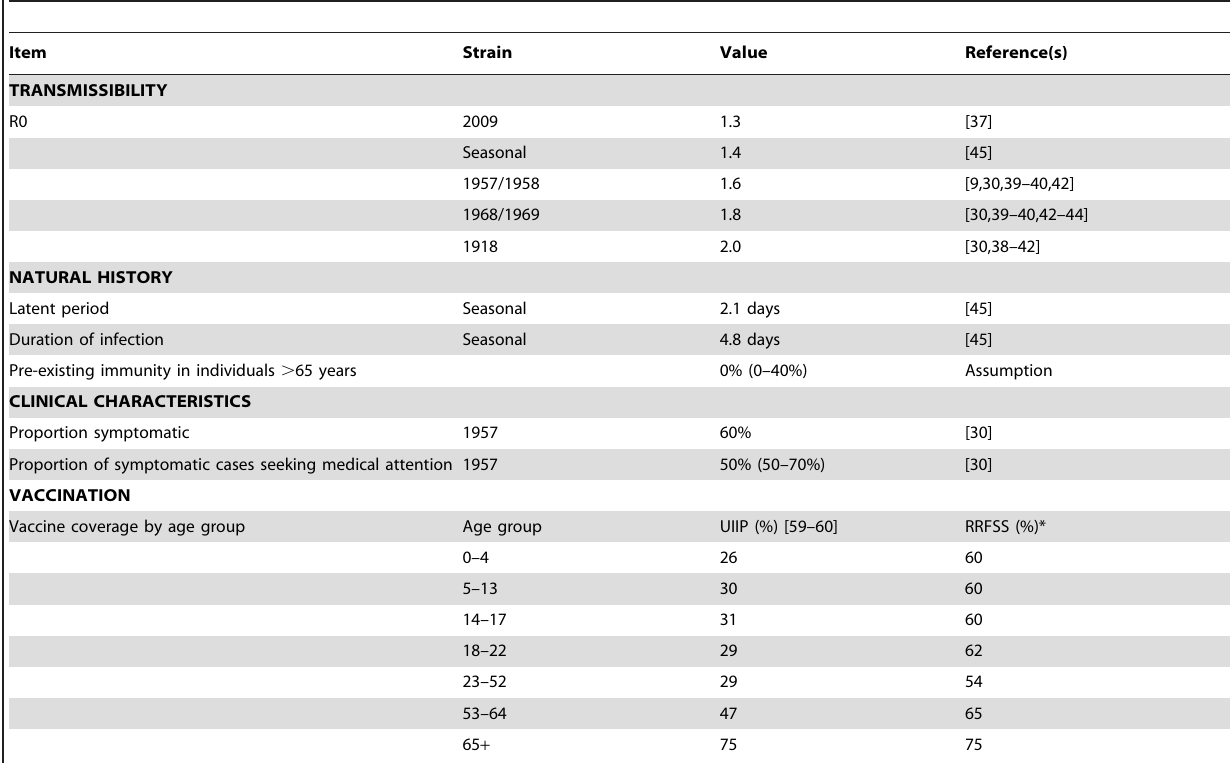
Table 3. Parameter values and assumptions used for the Canadian antiviral stockpile model.